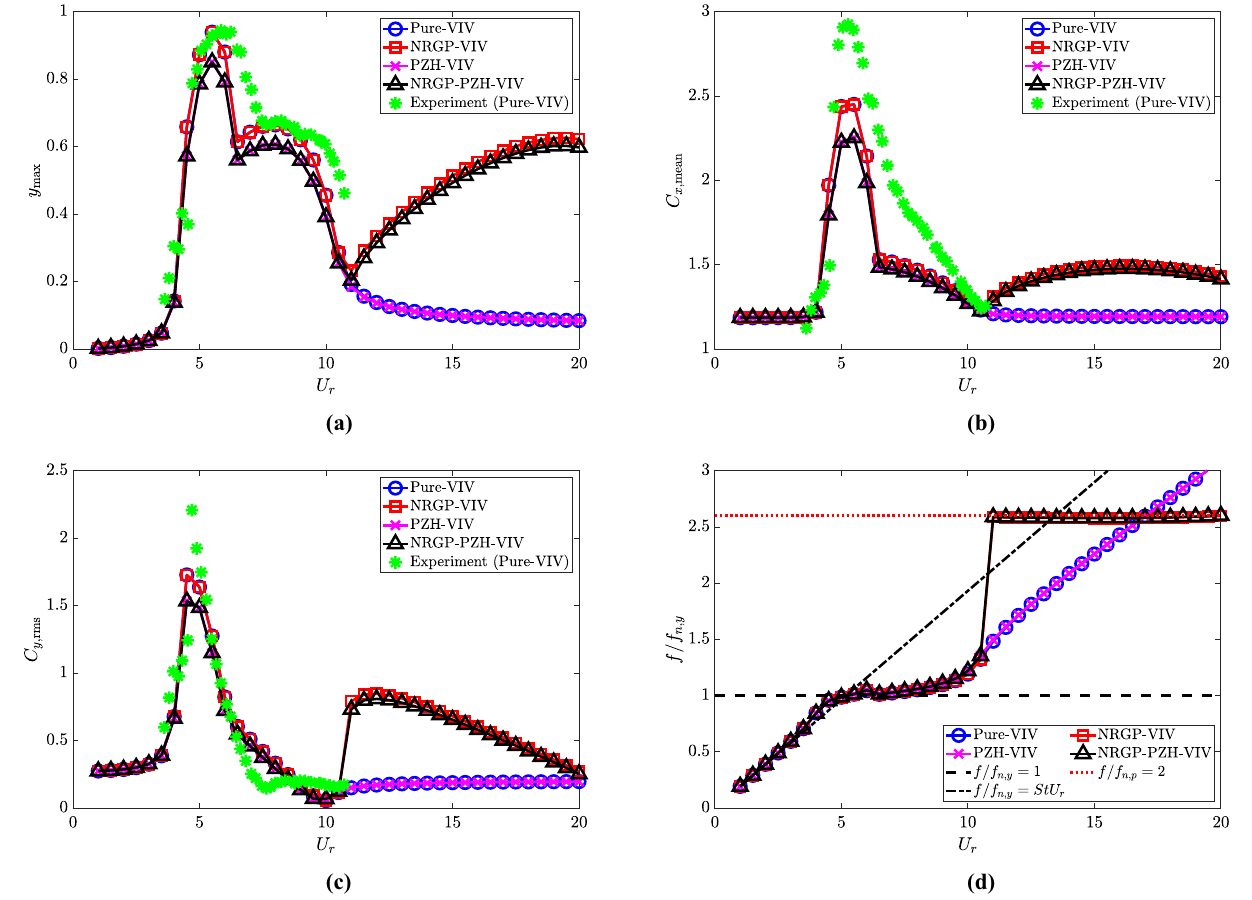
Figure 2. Response characteristics of the system with U r : ( a ) maximum non-dimensional oscillation amplitude ( y max ) of the cylinder, ( b ) mean in-line force coefficient C x ,mean , ( c ) root-mean-square cross-flow force coefficient C y ,rms , and ( d ) dominant frequency with respect to cylinder natural frequency f / f n , y . For the NRGP cases, m = 0.3 , l d = 0.1 , ω r = 1.3 and ζ θ = 0.0011